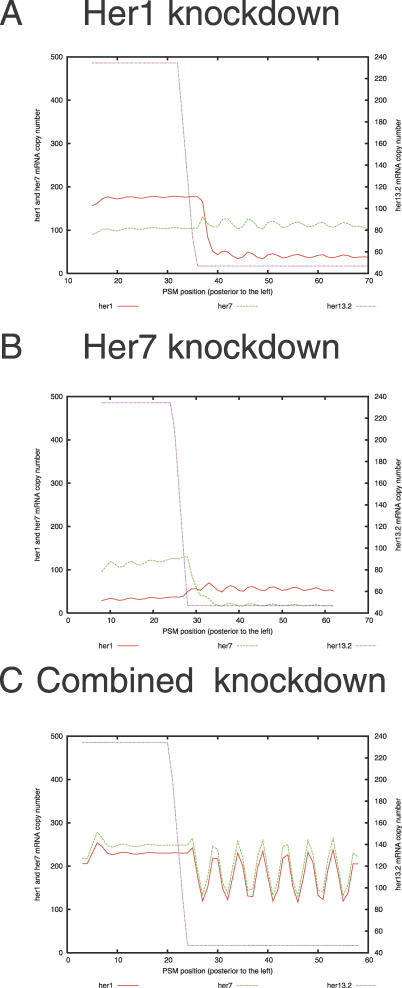
Simulated Translation Knockdown of her1 (A), her7 (B), and Combined her1 and her7 (C)For single knockdowns, residual oscillations of diminished relative amplitude were observed, and stripe formation in anterior PSM was disrupted. For the combined knockdown, her1 and her7 were upregulated and did not oscillate in posterior PSM, but did oscillate in a salt-and-pepper pattern in anterior PSM.